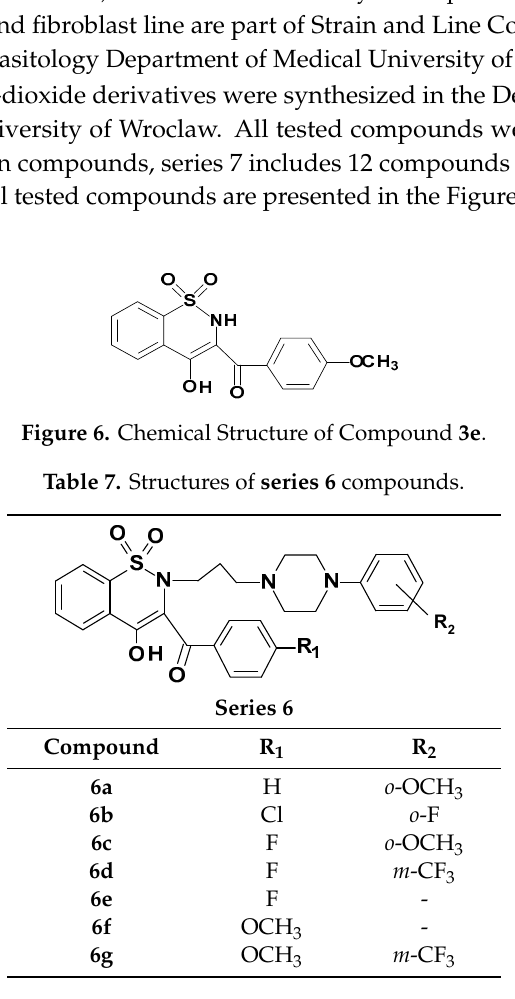
Table 8. Structures of series 7